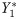
Time-dependent mutual information transmission in a simple biochemical circuit.a) Every well contains the same type of isogenic cell population where each well receives a different step input sampled from a uniform distribution. The resulting time series data is used to compute time-dependent mutual information. b) Schematic of pathway. c) Initial distribution of Y1* before any input is given, reflecting cell-cell variability in initial conditions. In this case, a single parameter set is used and the distribution is the result of intrinsic variability of the circuit. S1 denotes the mean of the distribution. d) I(x
+, y
1, t∣S1), I(x
+, M
y2, t∣S1), and I(x
+, y
2, t∣S1). e) Time-dependent dose-response relationships at t = 0, 75 and t = 750 minutes between y
2 and the input. The vertical black dashed line is where x
+ = 150 nM. f) Mutual information between y
2 and the input computed for heterogenous initial conditions (full distribution in panel c, black) and for homogeneous initial conditions (S1, red). Inset: same data but with time plotted to 2750 minutes and the MI plotted between 2.5 to 3 bits.